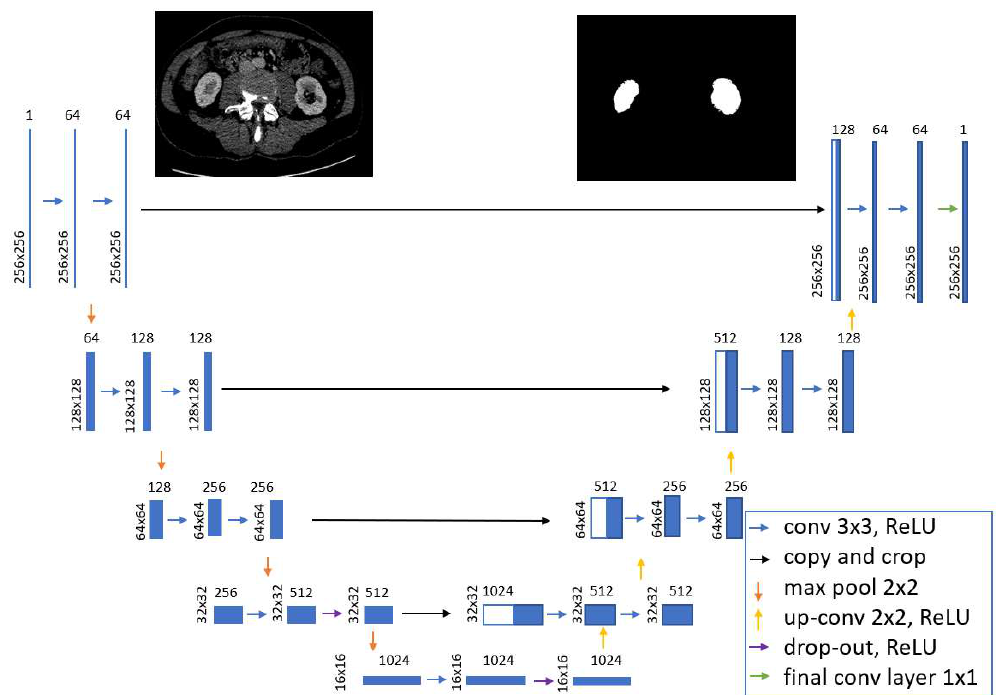
Figure 5. Diagram of the U-Net model used in the tests. The blue blocks represent a layer, on the left of each block the image size in each layer is marked. The number of image channels in the layer is placed above the block.